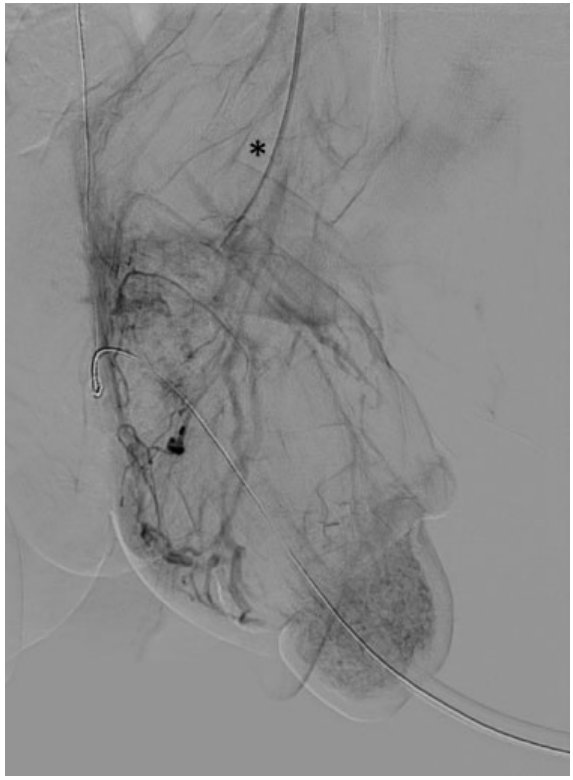
Fig.3 Venousphaseofthedigitalsubtractionangiography(DSA)oftheleft internalpudendalartery( (cid:1) )showedasuf fi